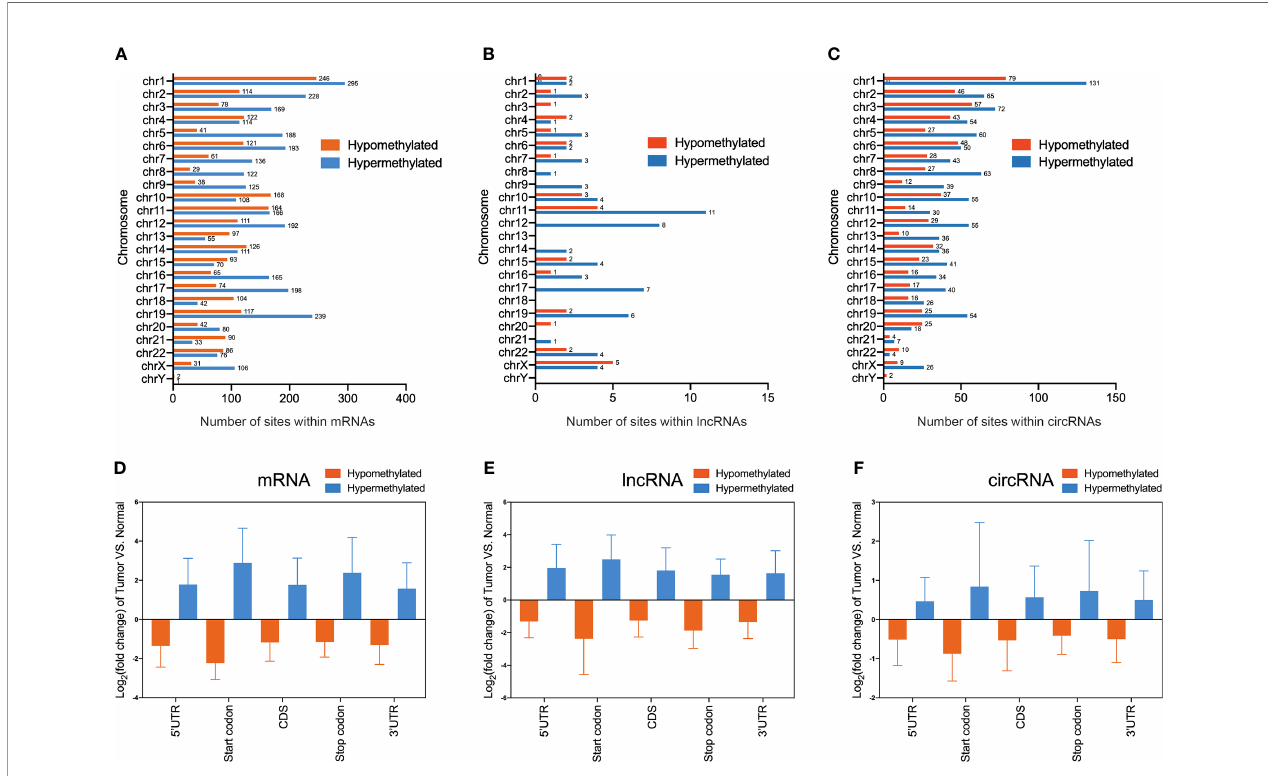
FIGURE 3 | Distribution of differentially methylated N 6 -methyladenosine sites between bladder cancer tissues and adjacent normal tissues. (A – C) Chromosomal distribution of all differentially methylated N 6 -methyladenosine sites within mRNAs (A) , lncRNAs (B) , and circRNAs (C) . (D – F) Statistics of fold change of differentially methylated N 6 -methyladenosine peaks within mRNAs (D) , lncRNAs (E) , and circRNAs (F) in fi ve